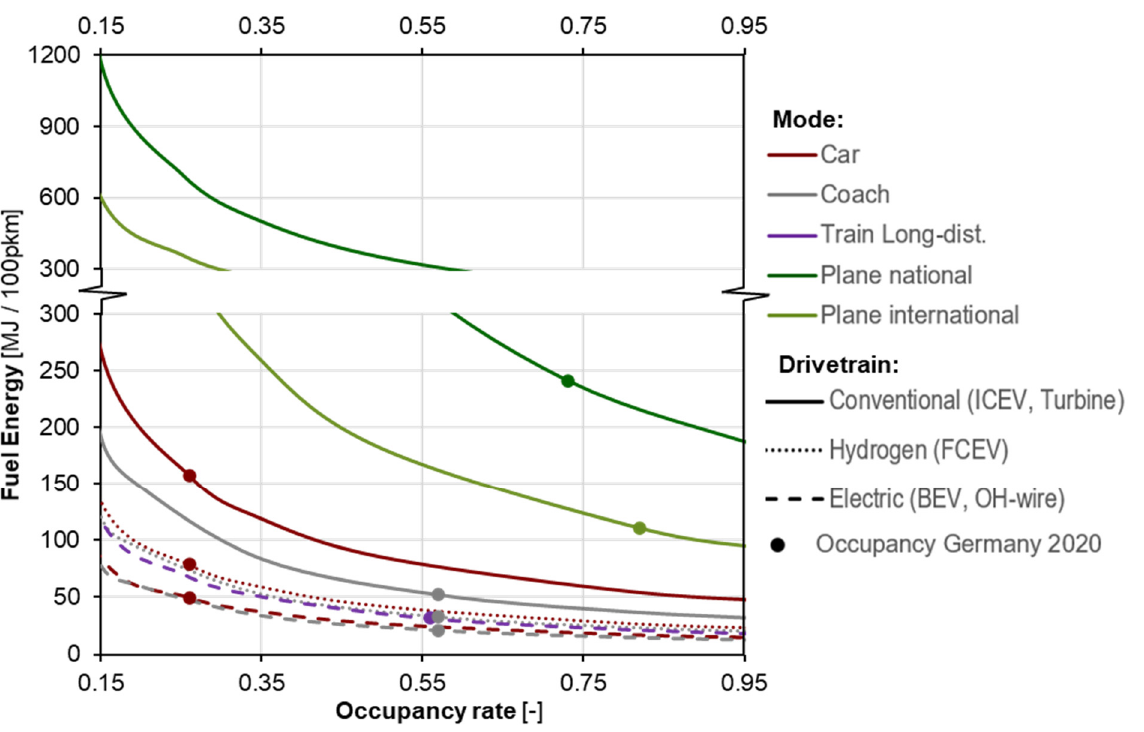
Figure 12. Fuel energy demand vs. occupancy rate for select long-distance passenger modes.